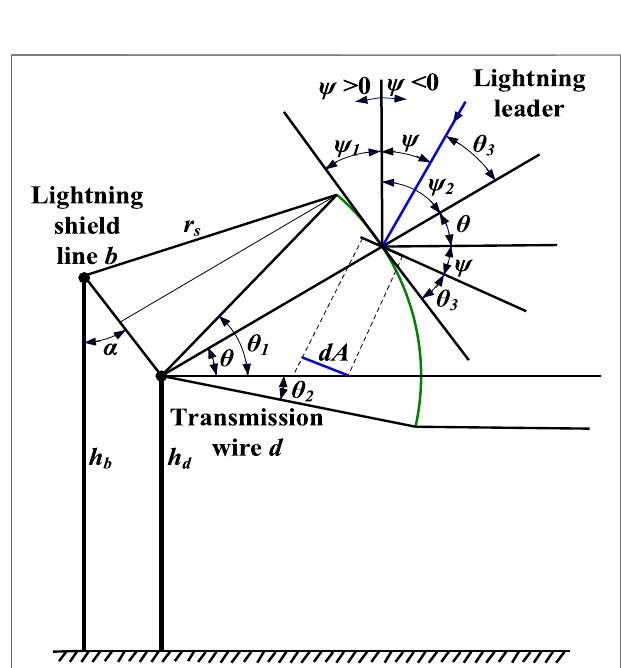
FIGURE 2 | Diagram of the EGM model for transmission lines in plains and mountainous areas. (A) Plains area. (B) Mountain area.